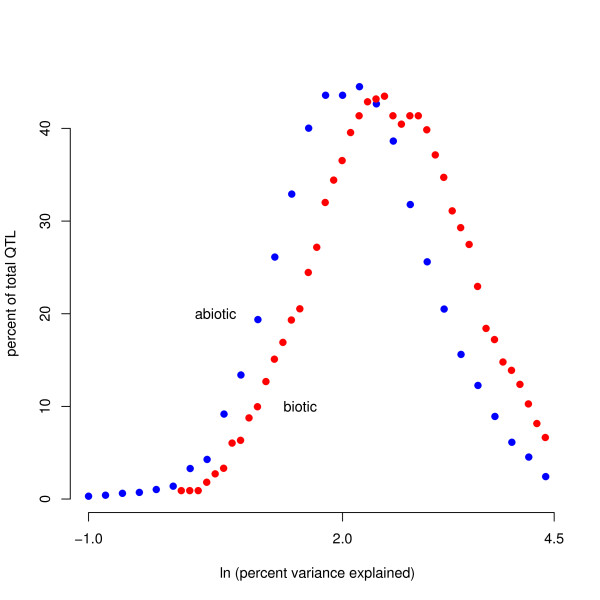
Log-transformed abiotic and biotic calculated PDFs (see methods). Sample sizes are the same as Figure 1.